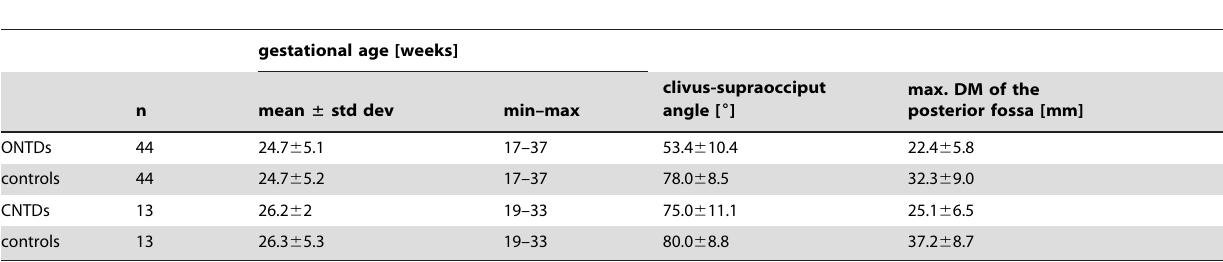
Table 1. Descriptive statistics of groups of fetuses with ONTDs and CNTDs and their respective control fetuses with normal CNS development.